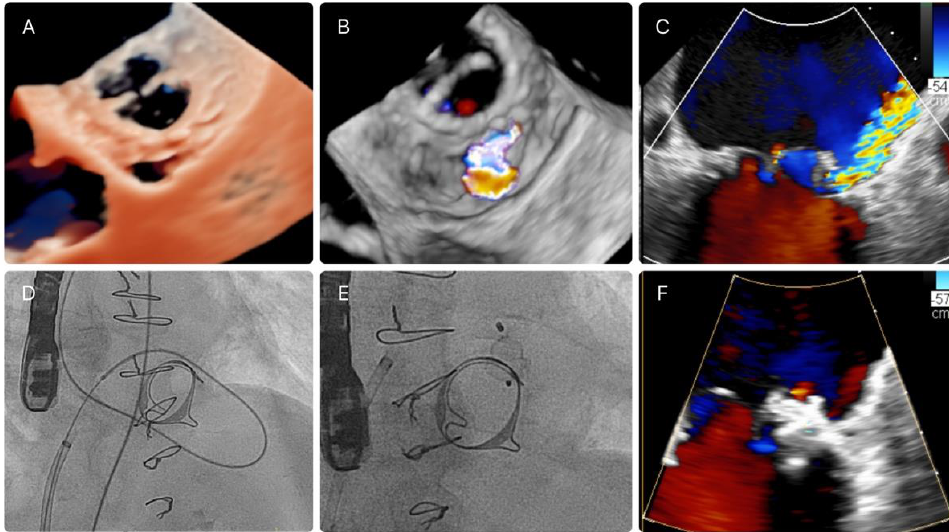
Figure 1. ( A , B ): mitral PVL by TEE with true-lumen technology and 3D-color TEE. ( C ): severe mitral regurgitation (septal PVL). ( D ): AV loop in a bioprosthesis. ( E ): AVP-III device. ( F ): nonsignificant mitral regurgitation after PVL closure (Doppler color TEE).